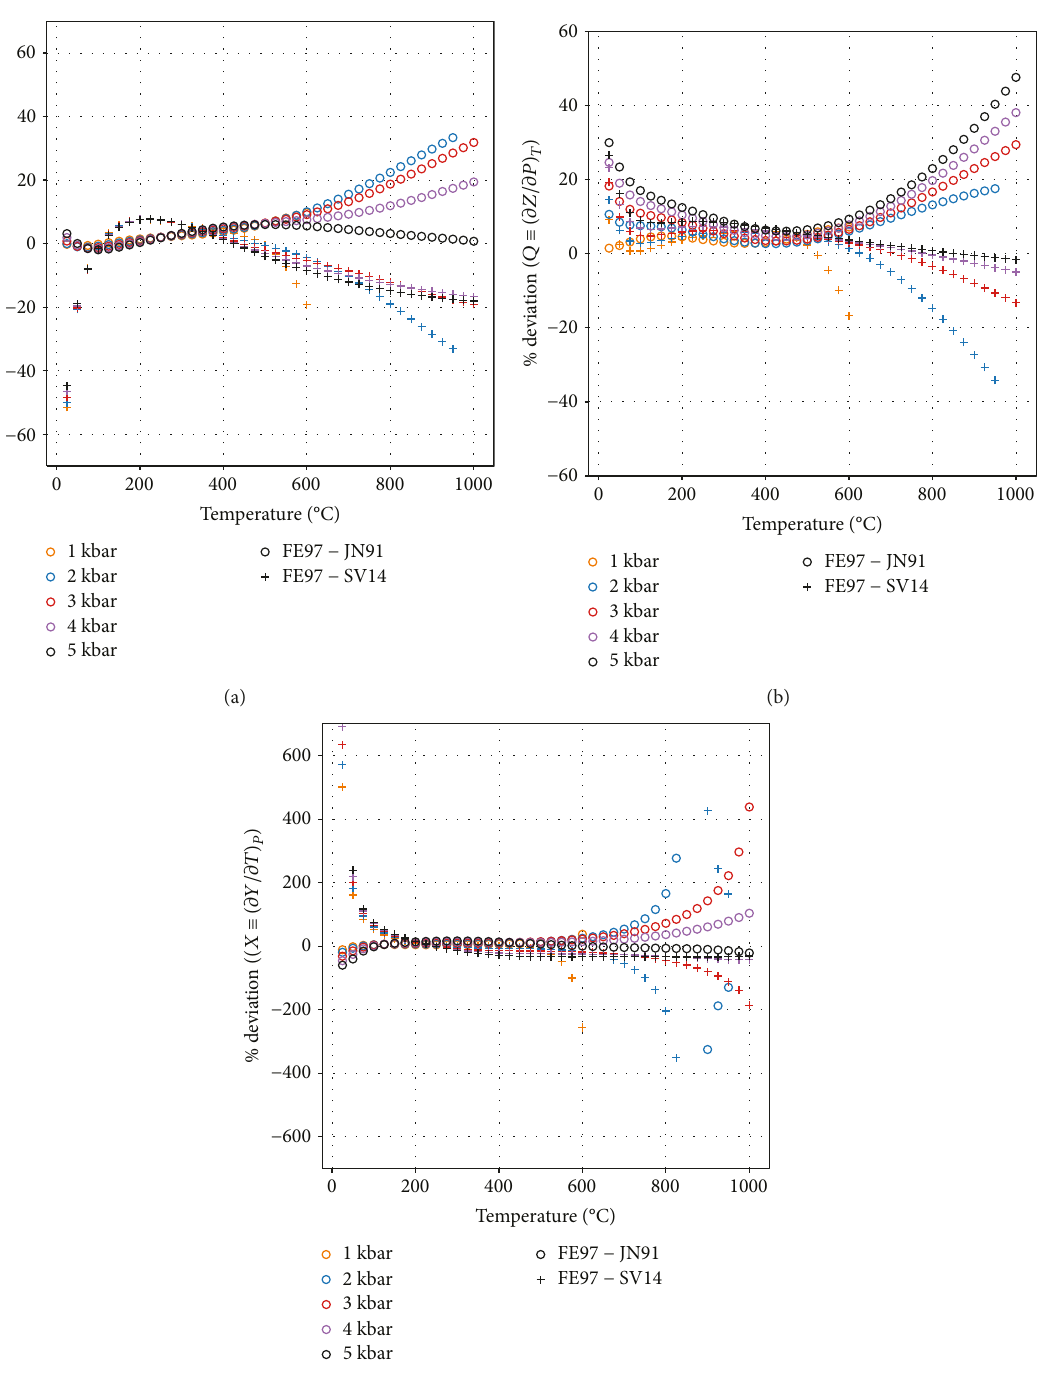
Figure 3: Percent deviation of property values calculated with the JN91 and SV14 models from those obtained using the FE97 model, where the IAPWS95 model is used for ρ (25 – 1000 ° C, 1 – 5 kbar): (a) Born Y , (b) Born Q , and (c) Born X H 2 O